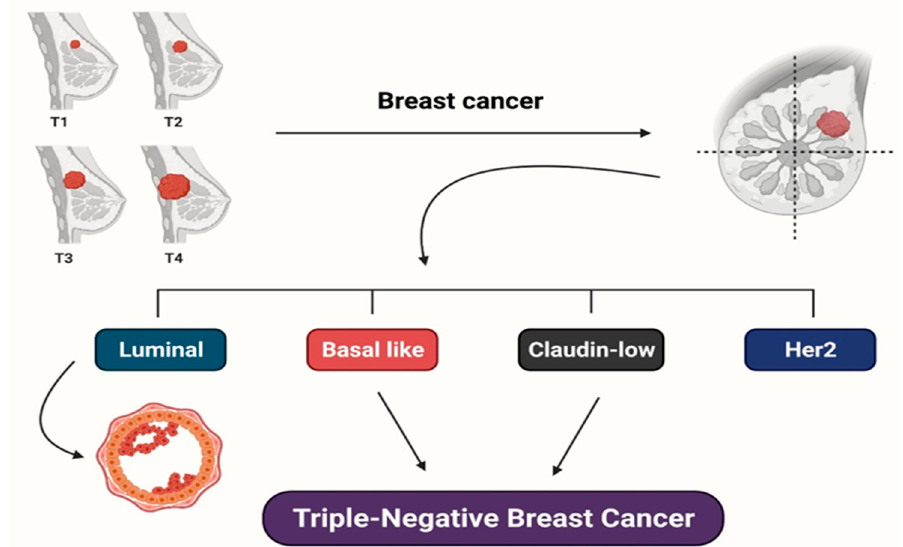
Figure 1. Molecular subtypes of breast cancer and triple-negative breast cancer types are depicted. Overall survival (for breast cancer subtypes) and relapse-free survival (for TNBC subtypes) are used to distinguish the subtypes.